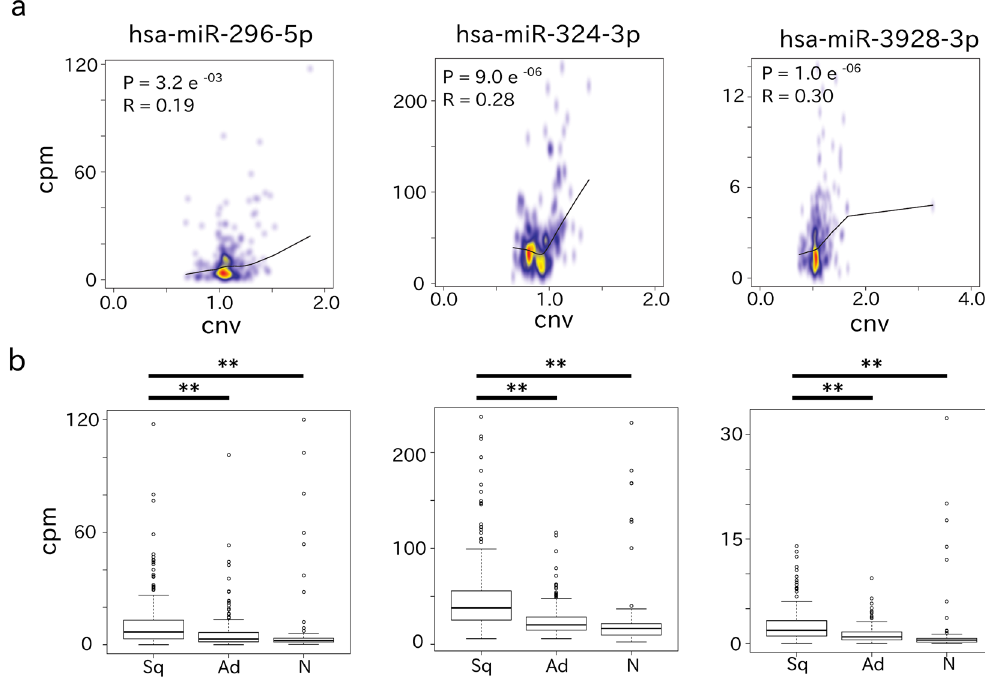
Figure 3. Characteristics of the three miRNAs associated with poor prognoses. ( a ) Density scatter plots showing the association between miRNA (miR-296-5p, miR-324-3p, and miR-3928-3p) expression and CNV in the precursor locus, particularly for copy number gains. The curved line was estimated with R function “lowess”. ( b ) Boxplots showing the higher expression of the three miRNAs of interest in Sq samples relative to those in Ad and normal (N) samples. P-values were calculated with the Wilcoxon rank sum test: ( * ) P-value < 0.05; ( ** ) P-value <